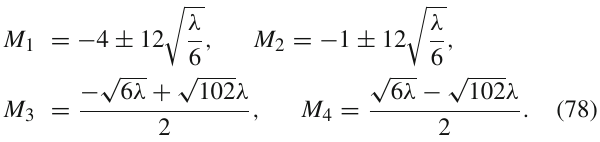
dynamical system Eqs. (60)–(63). From the figure the trajec- tories of the critical points A 2 and C 2 move away from the fixed points. Hence these points ( A 2 , C 2 ) are unstable sad- dle. We analyze that for critical points A 2 and C 2 the density parameters are (cid:3) m = 1, (cid:3) r = 0 and (cid:3) (cid:4) = 0 and the EoS shows that the phase of the Universe is parameter ω ef f = − 1 3 quintessence and q = 0 shows that the Universe is